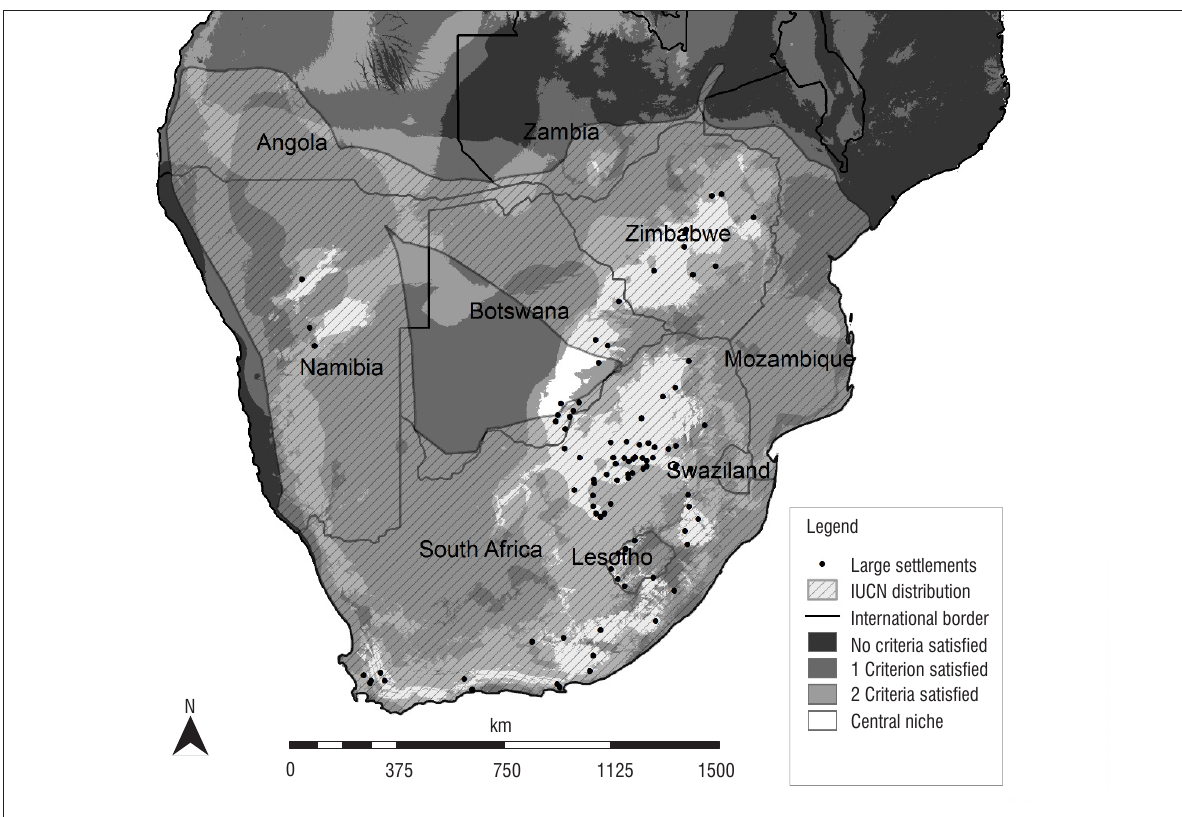
Figure 4: African settlements of >20 000 people within the predicted environmental central niche, overlaid with the IUCN distribution of the chacma baboon.